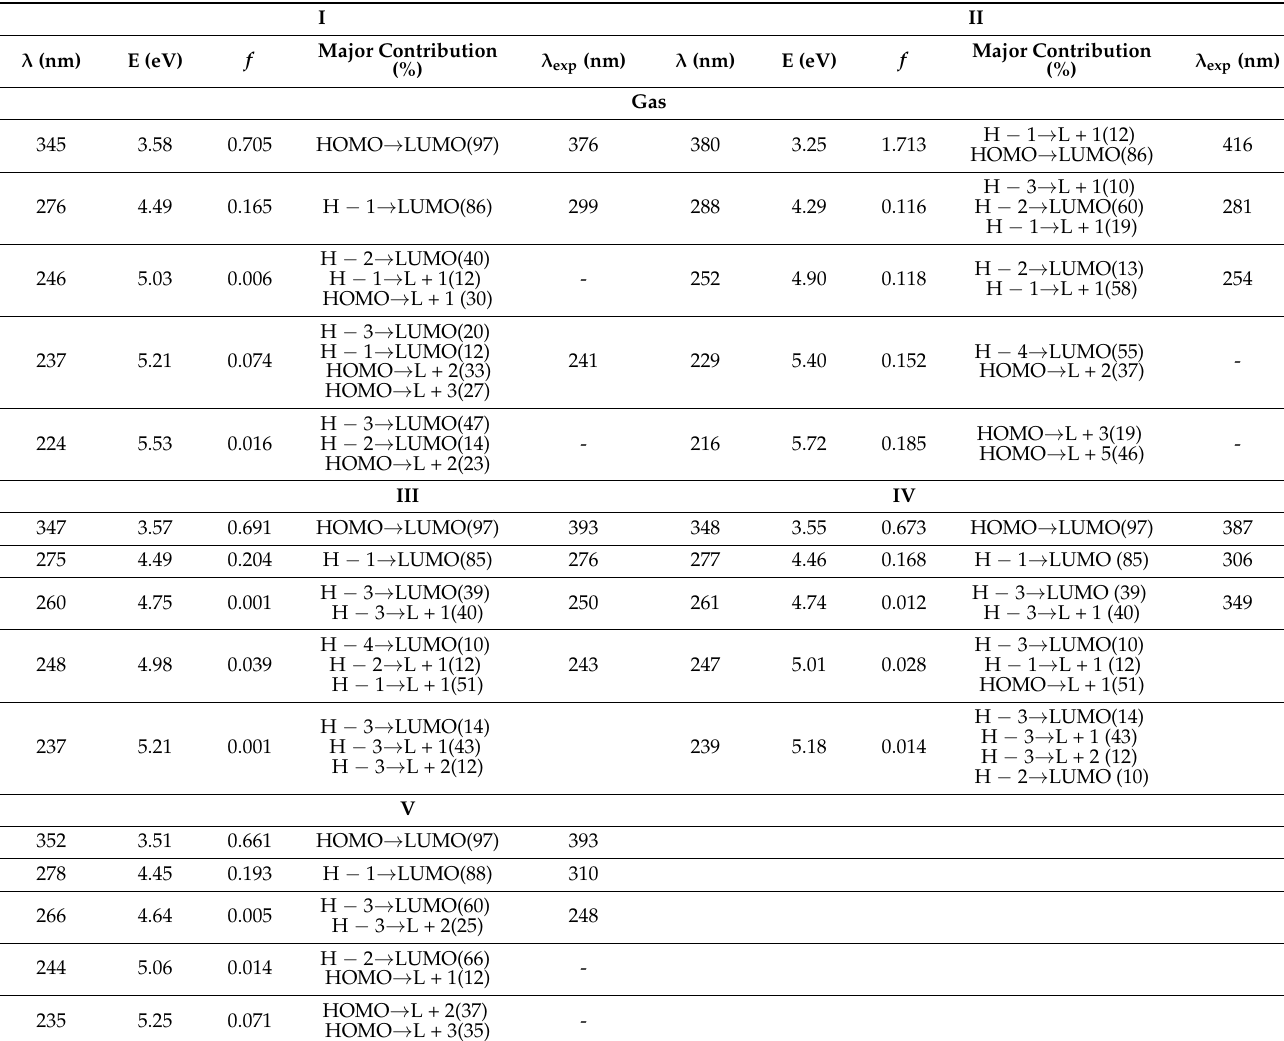
Table 1. Absorption wavelength (nm), excitation energy (eV) and oscillator strengths ( f ) of I – V compounds. Experimental and calculated at theory level of